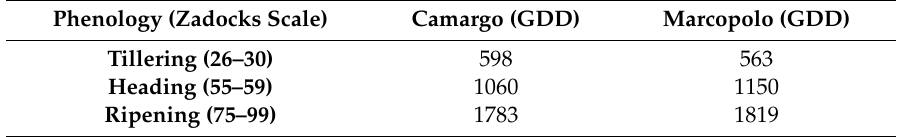
Table 2. Estimated phenological day of year regarding GDD average (Table 1) for the seasons analyzed (2018 and 2019).